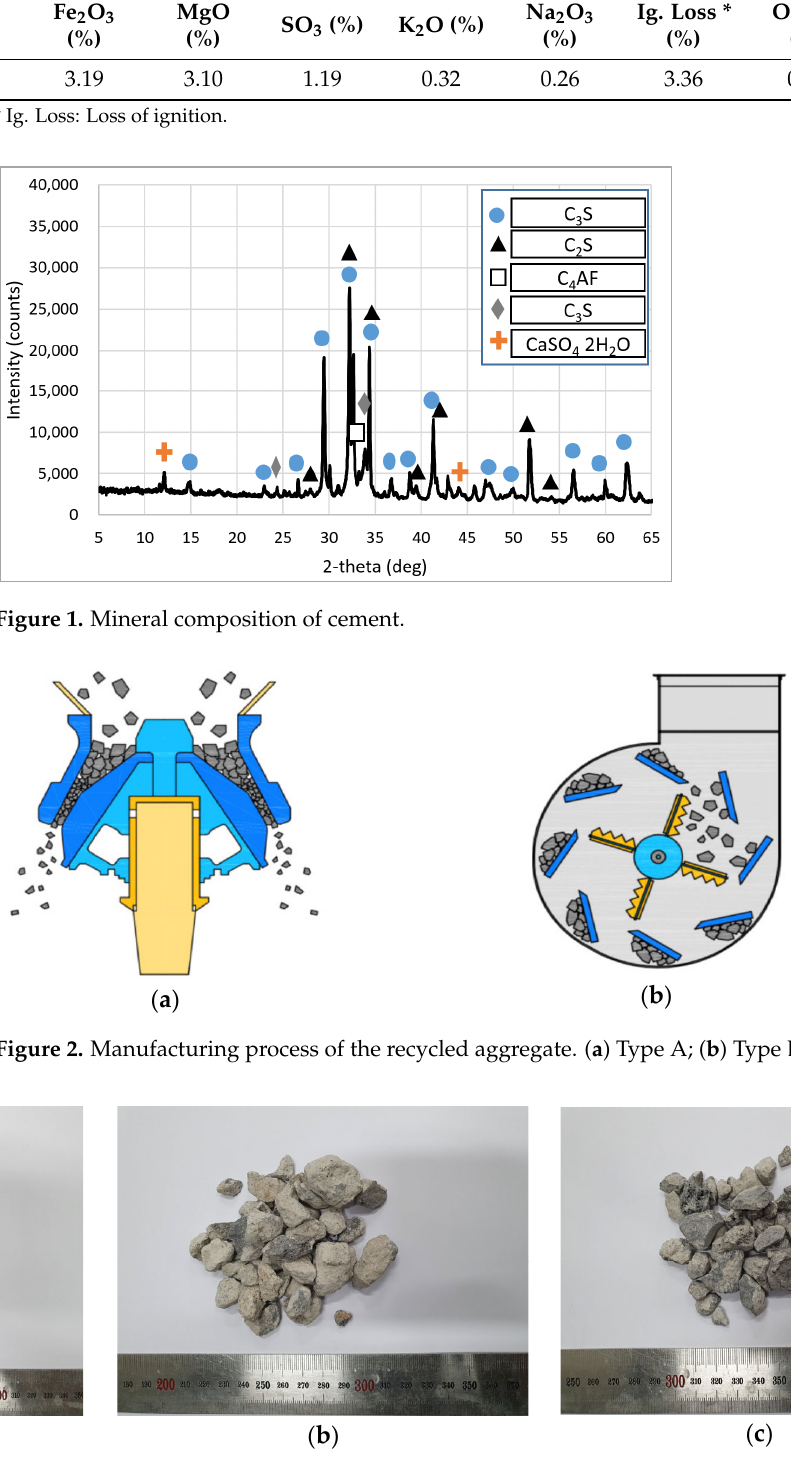
Figure 3. Using the coarse aggregate. ( a ) BA; ( b ) RRA; ( c ) PRA .